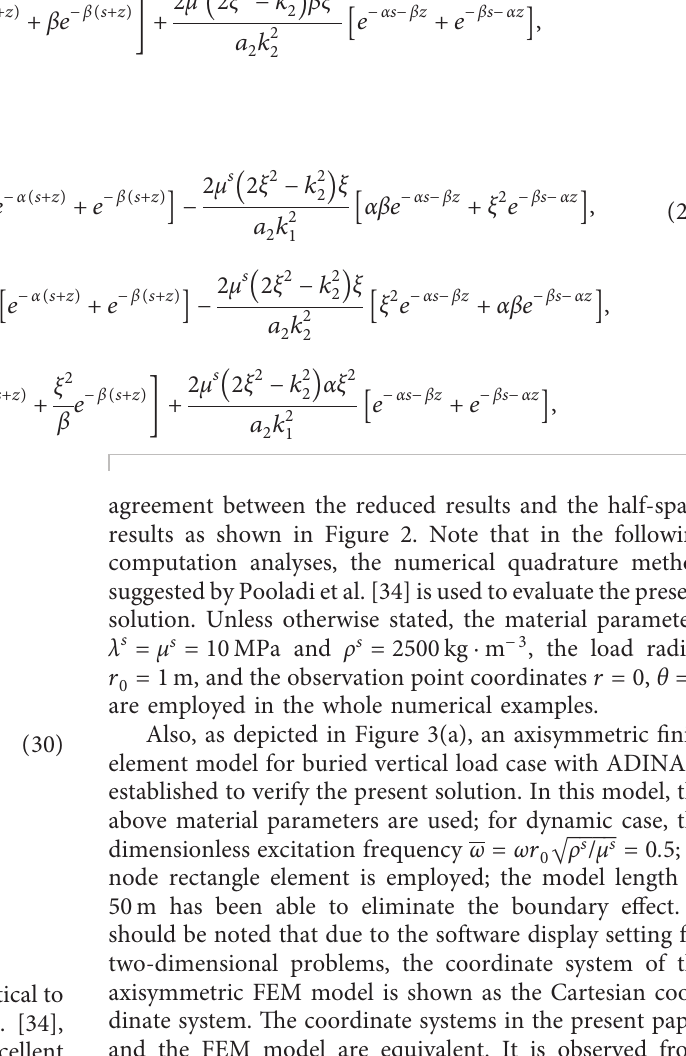
Figure 2: Lateral displacement u